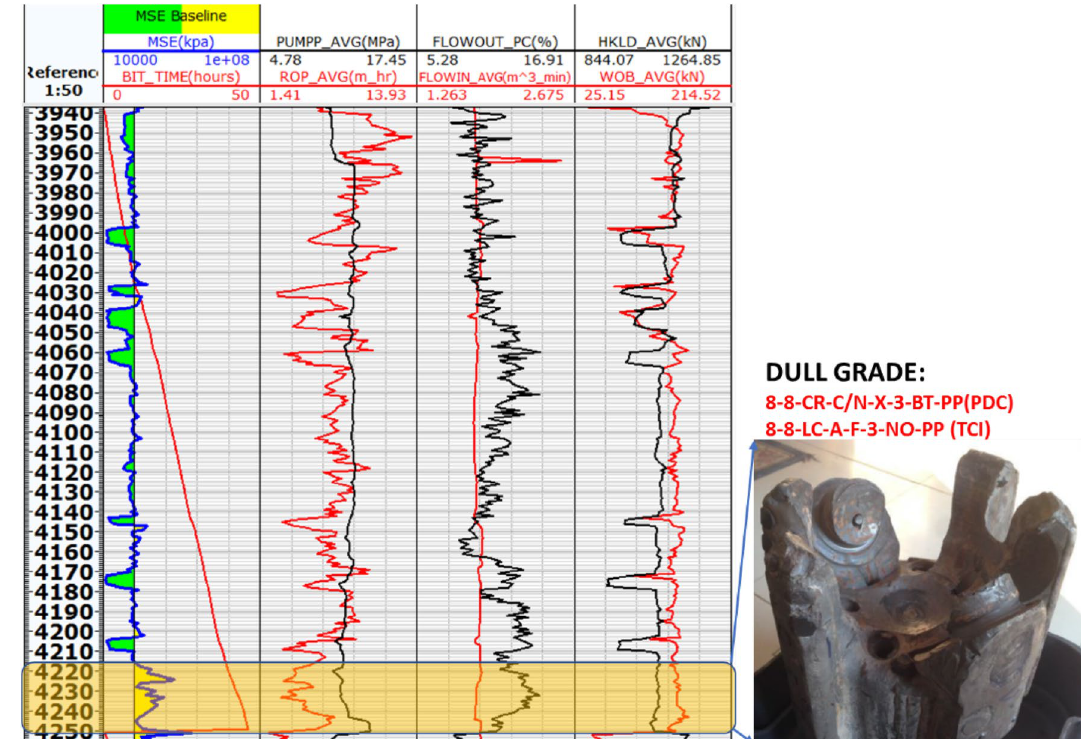
Fig. 1 Graphical representation of MSE and surface drilling parameter in Well